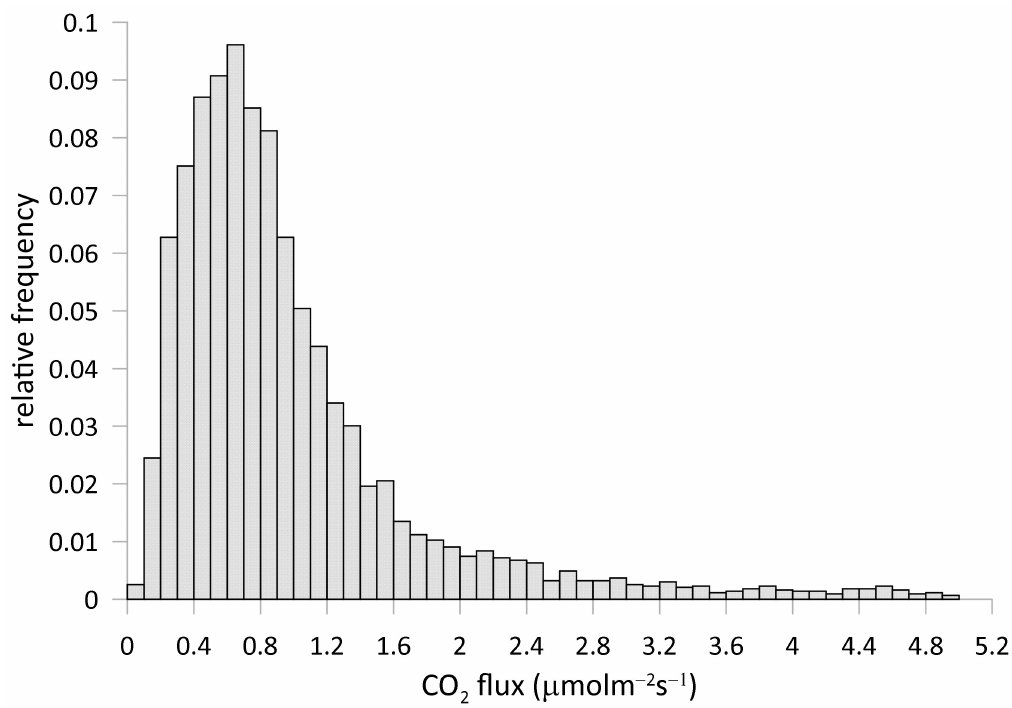
Figure A2. Relative frequency distribution of the absolute random errors at an hourly scale for the CO 2